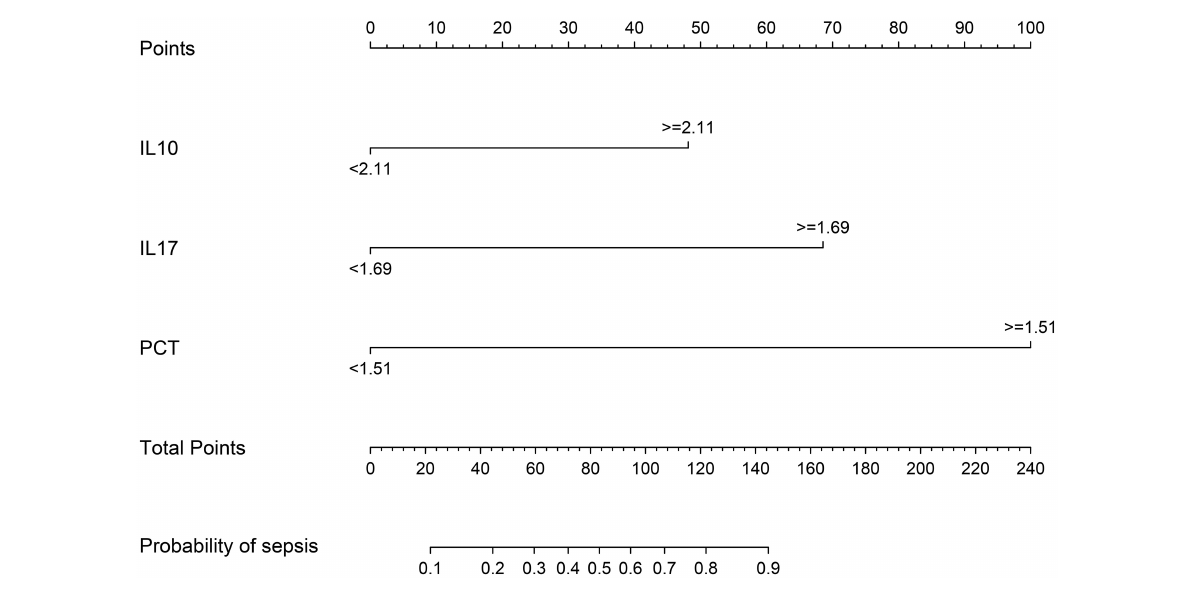
FIGURE8 The nomogram predicting the risk of sepsis in infected patients.